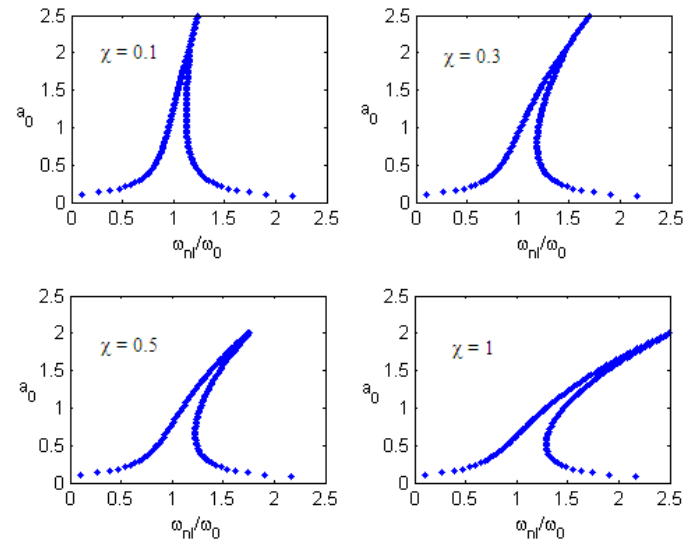
Figure 9. Frequency-response curves versus amplitude for different values of χ ( α = 1, C = 0.025, Cp = 0.025, wo = 1, ¯ F = 0.2).